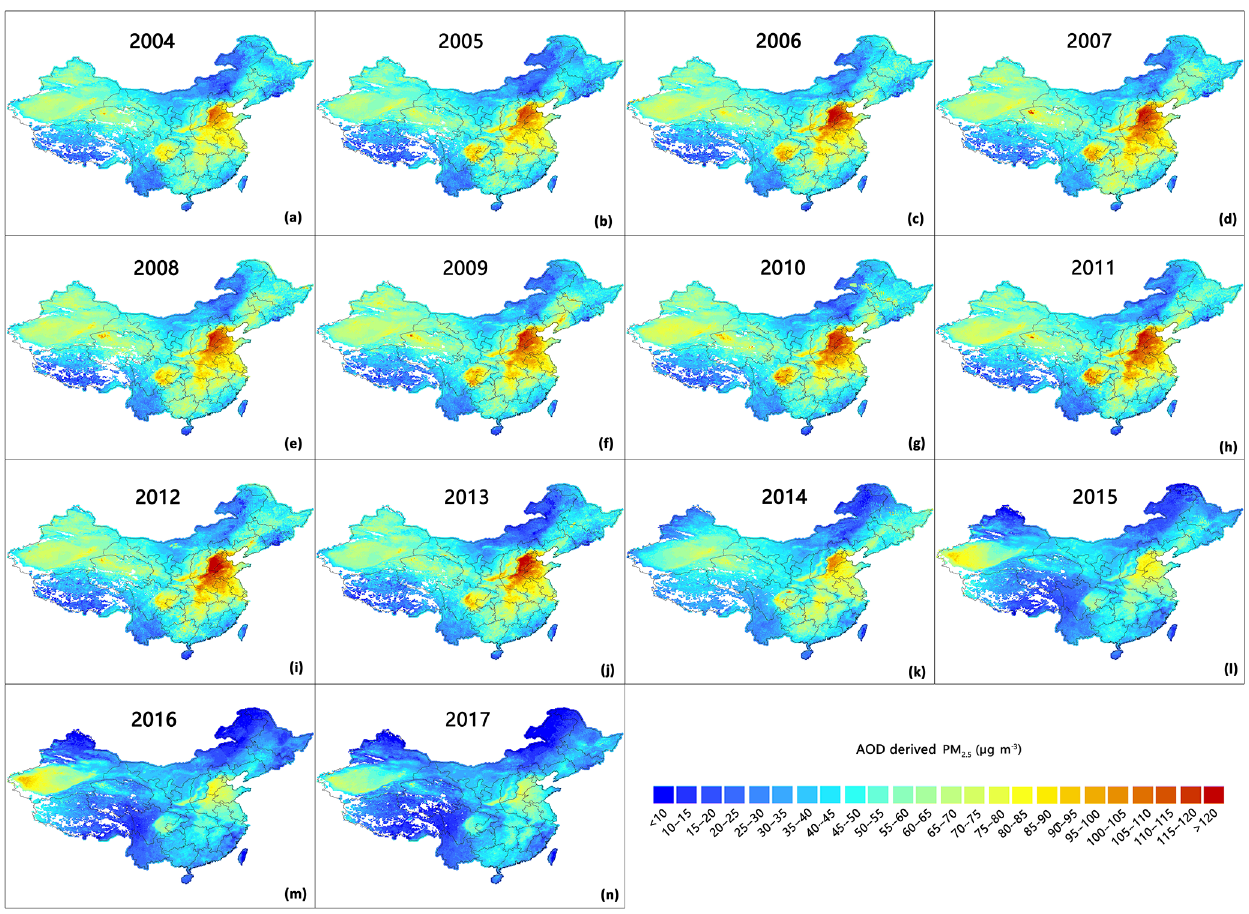
Figure 4. Spatial distributions of annual mean satellite-derived PM 2 . 5 concentrations from 2004 to 2017.